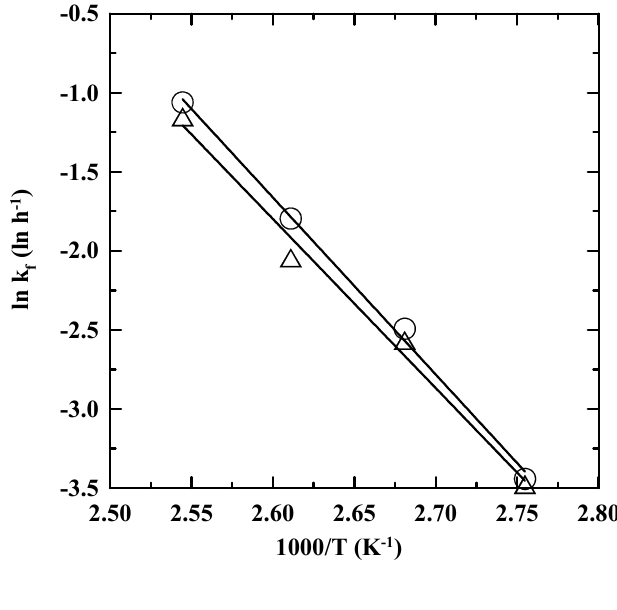
for the consumption of PDA in the SNME f = − 11194.57/T (K − 1 ) + 27.4, f = − 10693.11/T (K − 1 ) + 26.0, R 2 = 0.990) , f